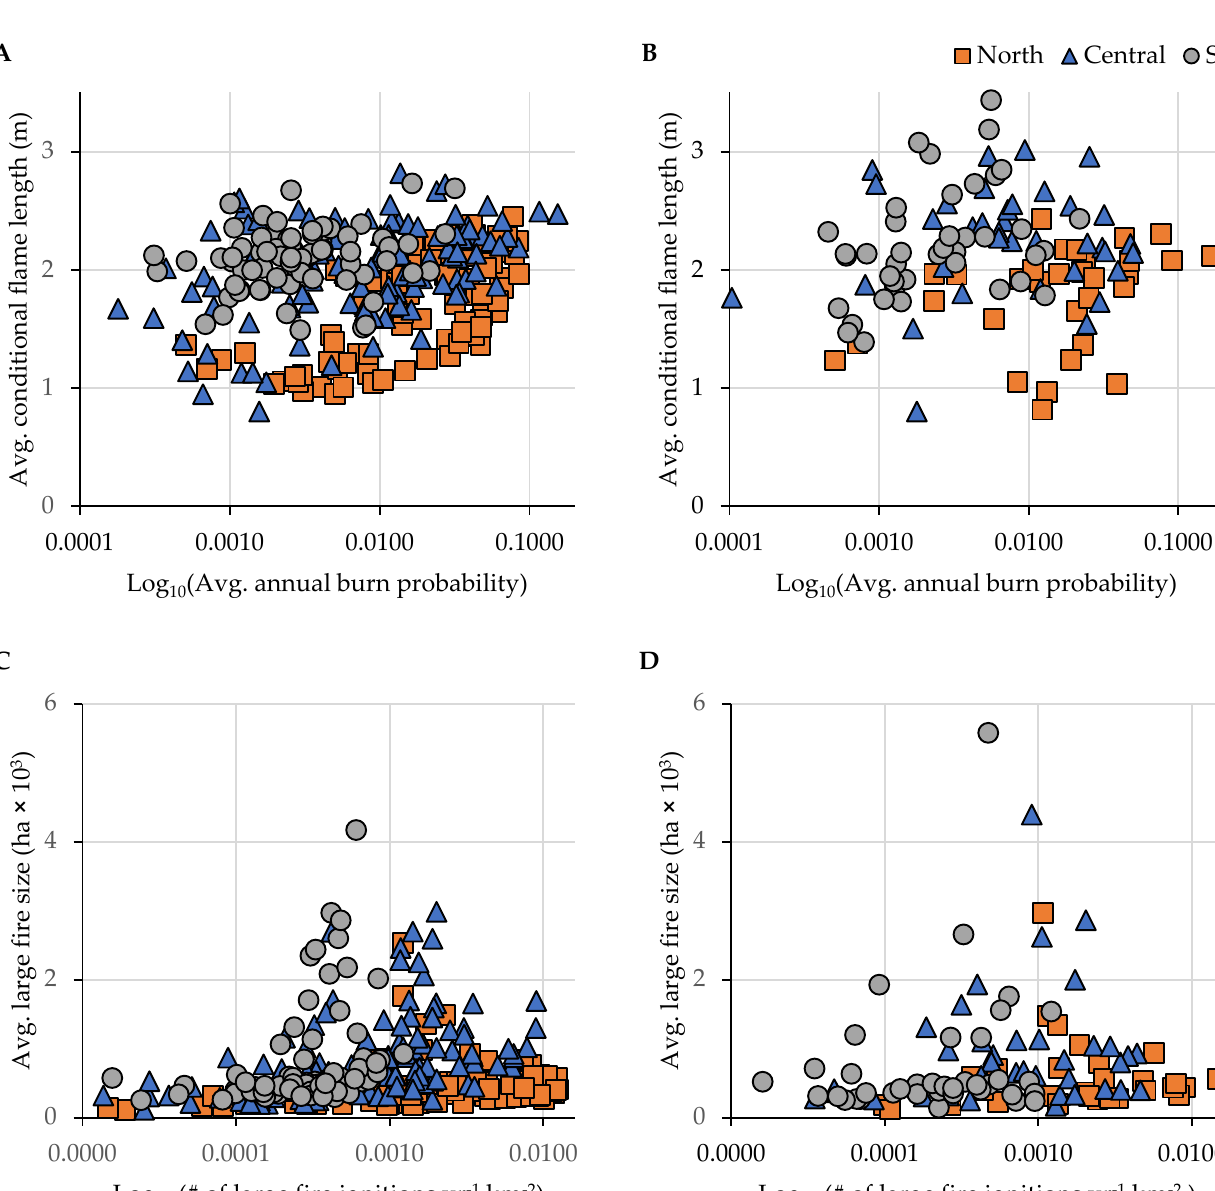
Figure 4. Wildfire exposure scatter plots of the human communities (left) and natural protected sites (right). Each dot represents the average annual burn probability vs. conditional flame length (m) ( A , B ), and the average large (>100 ha) fire size (ha) and wildfire occurrence (# ignitions yr −1 km −2 ) ( C , D ).